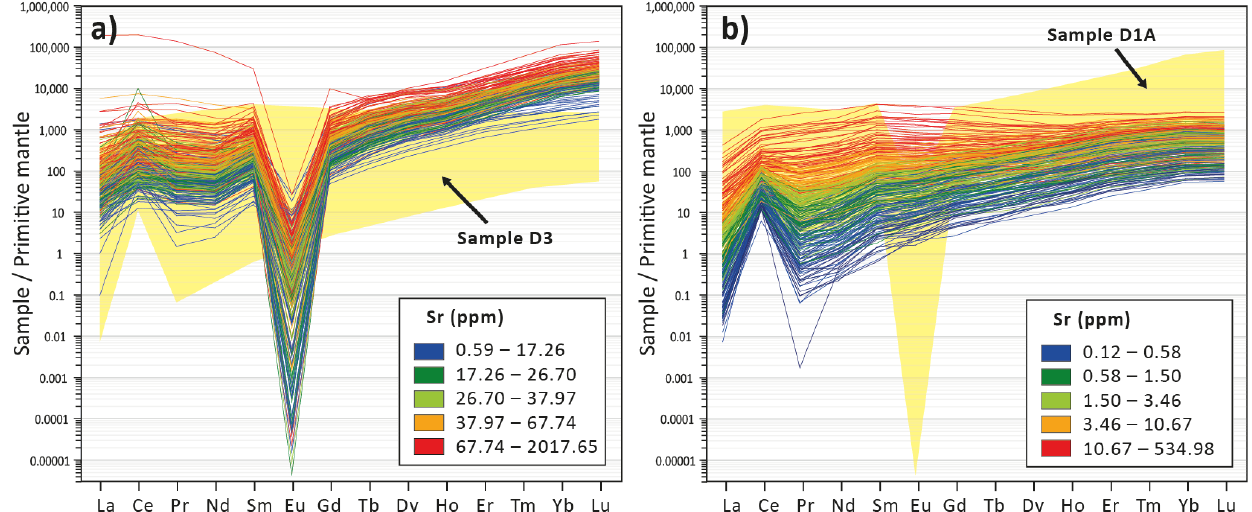
Figure 8. Chemical composition of 322 and 292 zircon grains from, respectively, the D1A ( a ) and D3 ( b ) samples. Zircon chemistry is also displayed on a primitive mantle-normalized [42] REE plot. The color code displays the Sr content of the grains, with values classified using the centile method. The yellow outline, in the background, corresponds to the range of values obtained for the opposite grain.